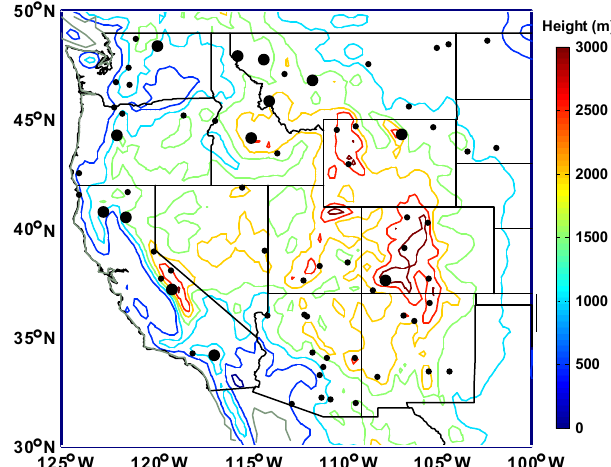
Figure 1. IMPROVE sites (data available at http://vista.cira. colostate.edu/improve/; solid circles) in the western United States (WUS). We use all the 69 sites in the standard inversion Case 1 (Ta- ble 1). Small 56 solid circles represent the sites used in the inversion Case 6 (Table 1). Also shown are terrain heights (color